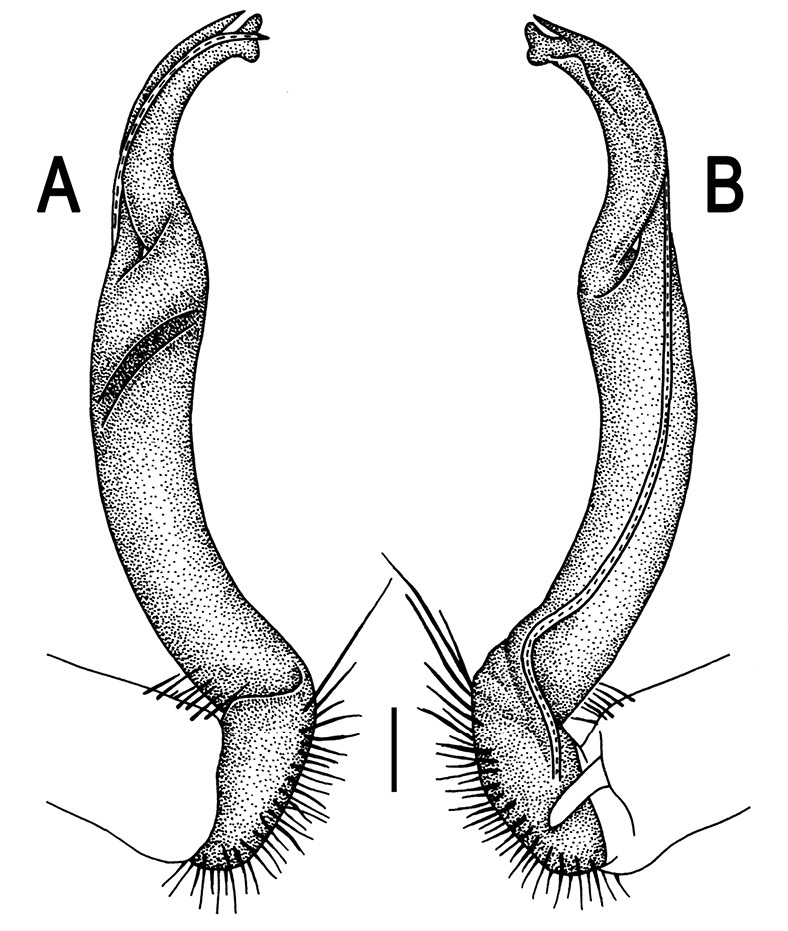
Orthomorpha pterygota Golovatch, 1998, ♂ from Panwa Cape. A, B right gonopod, lateral and mesal views, respectively. Scale bar: 0.2 mm.